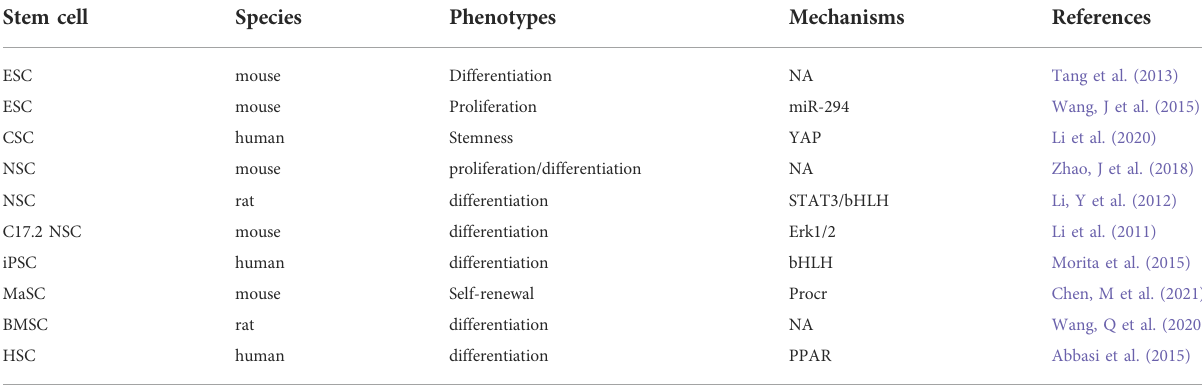
TABLE 2 The alternations and in fl uences of Baicalin on cellular processes in various stem